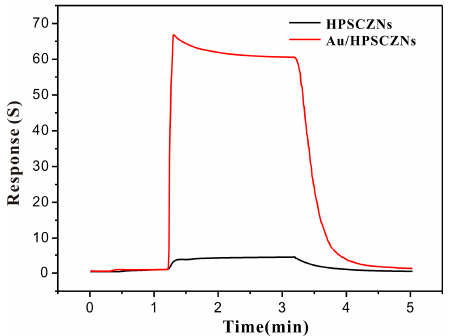
Figure 9. Response curves of the unmodified and the Au-modified HPSCZNs sensors to 30 ppm of TMA at 260 °C.